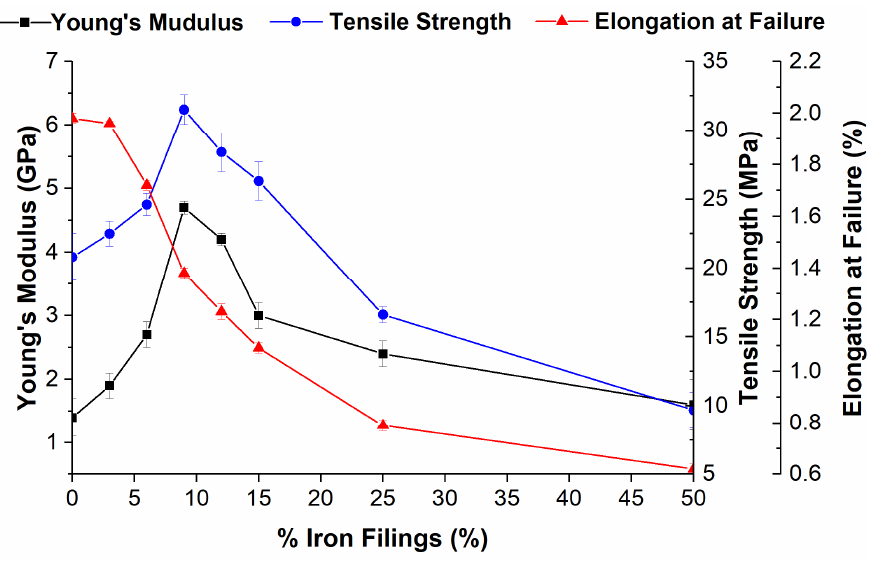
Figure 5. The mechanical properties (Young’s modulus, tensile strength, and elongation at failure) of the GFRE composites upon the addition of different WIF amounts.